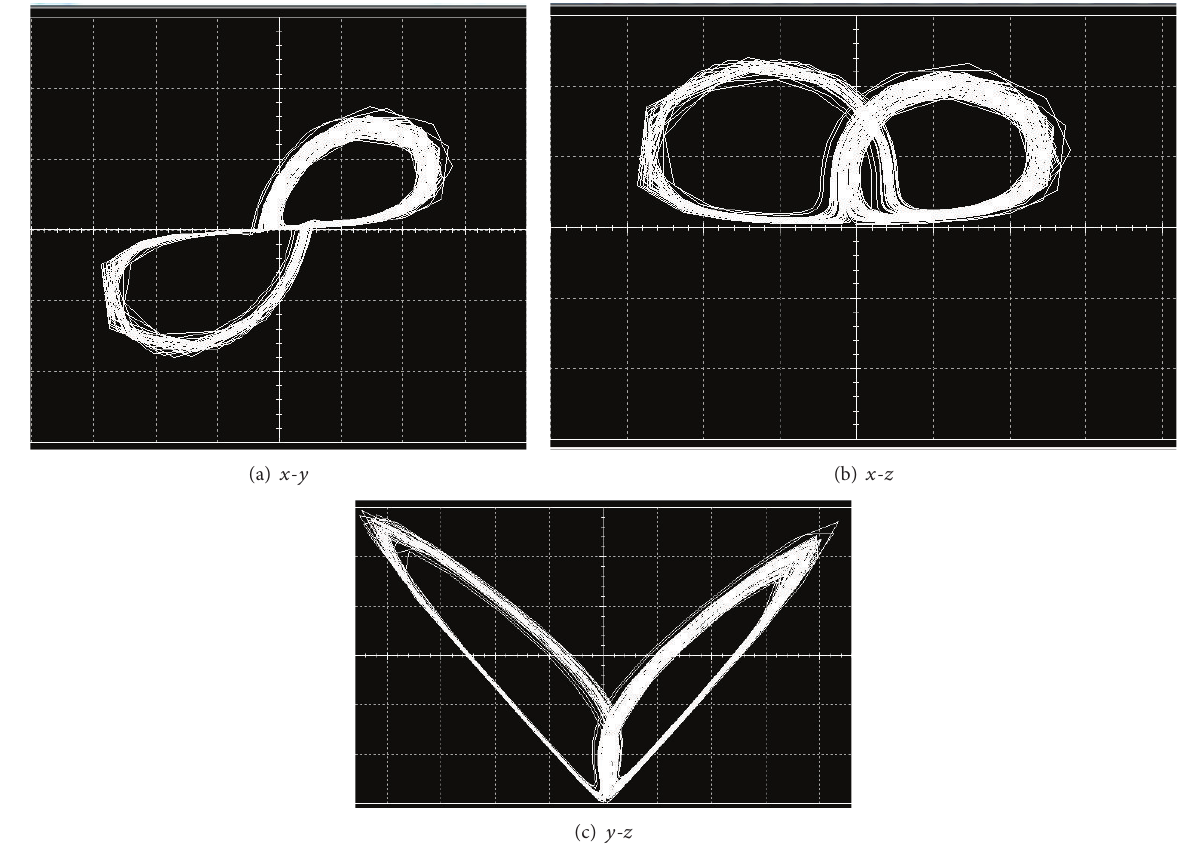
Figure 5: Circuit simulation results of the new fractional-order chaotic system